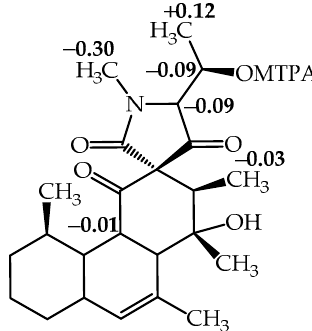
Figure 4. Δ 𝛿 SR values (ppm) for the C-5 ′ α -methoxy- α -trifluoromethylphenylacetyl (MTPA) esters of compound 1 .